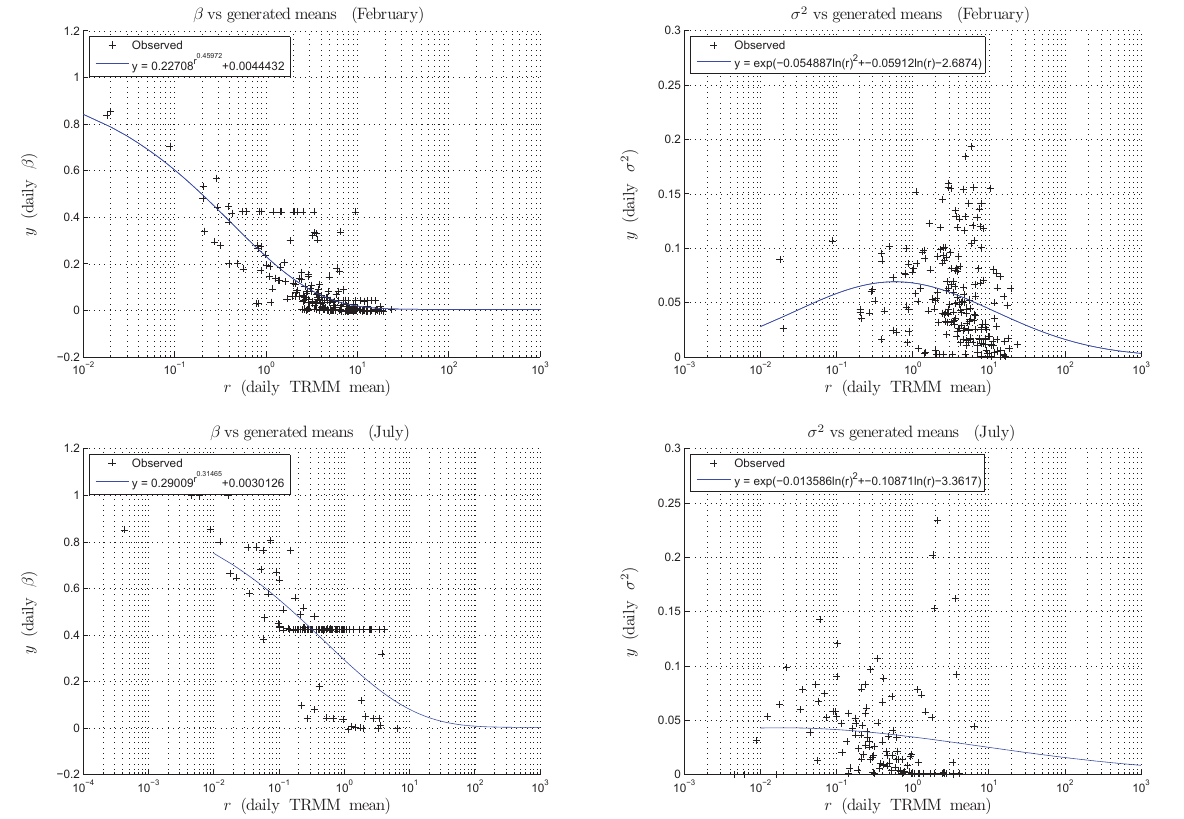
Figure 8. Relationship between β and the daily TRMM mean values for the months of February, May, August and December for the period of 1999–2006.